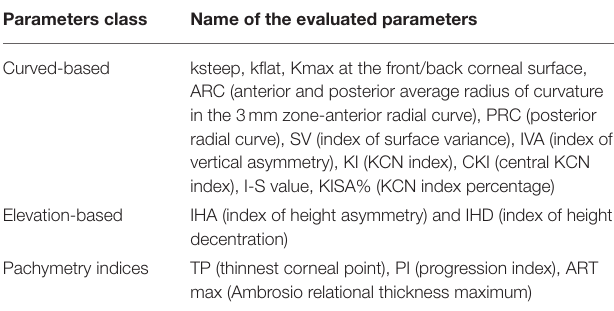
TABLE 1 | Evaluated Pentacam